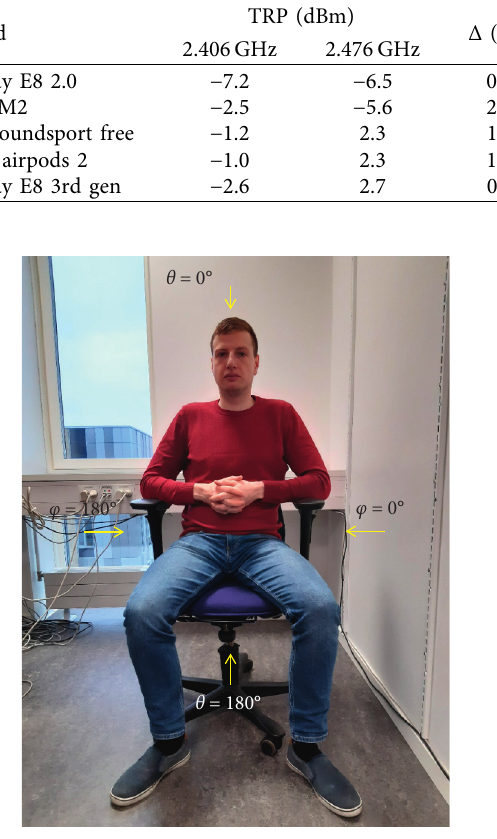
Figure 5: Coordinate system used in the